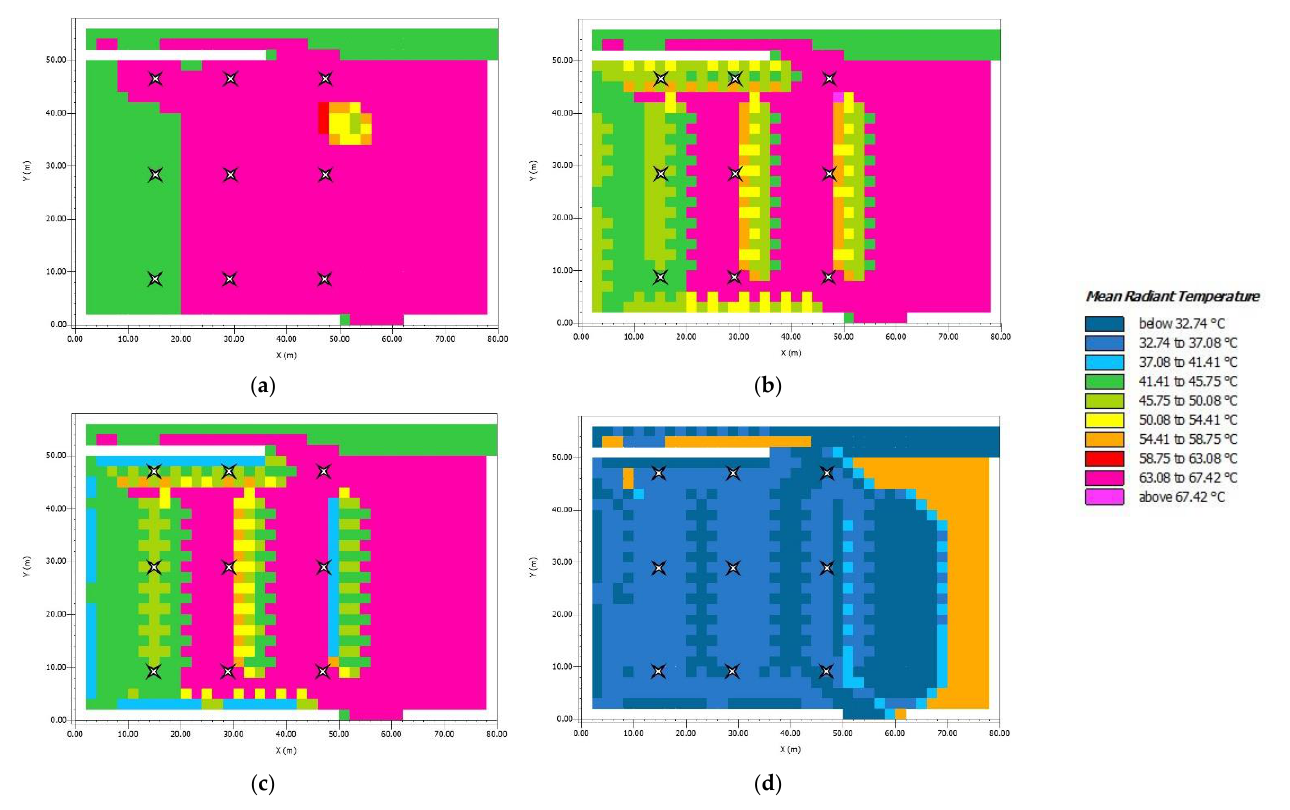
Figure 10. MRT at 04.00 p.m. in July. ( a ) AS; ( b ) LC+G1; ( c ) LC+G2; ( d ) LC+G3.